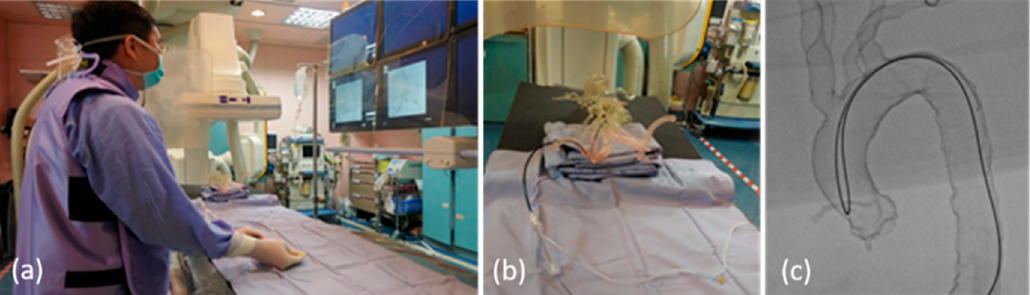
Figure 4. ( a ) Photo of the training program using the vascular simulator in the angio-suite; ( b ) photo of the vascular simulator setting in the angio-suite; ( c ) the fluoroscopic image of the SIM2 catheter manipulation in a vascular simulator with type III aortic arch.